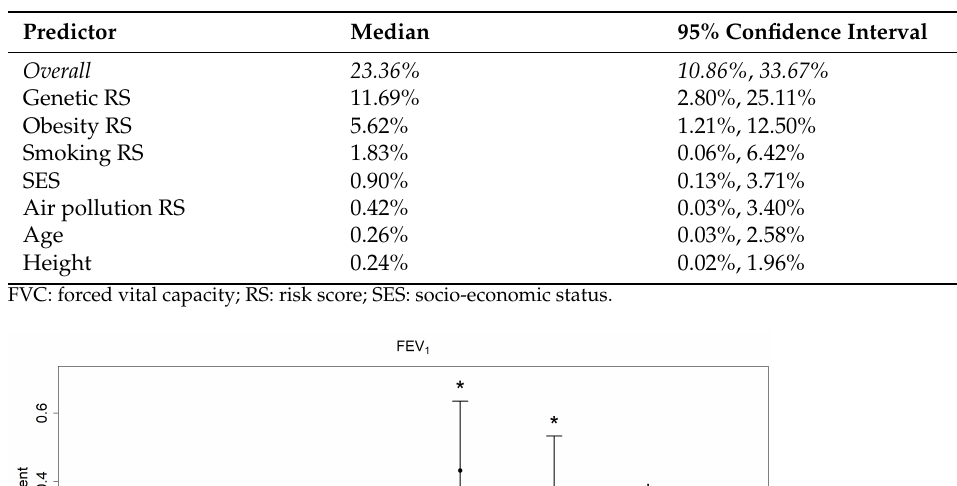
Table 4. Relative Contributions (bootstrap median and 95% percentile confidence interval) of the predictors for FVC, as percentages, sorted according to the median.